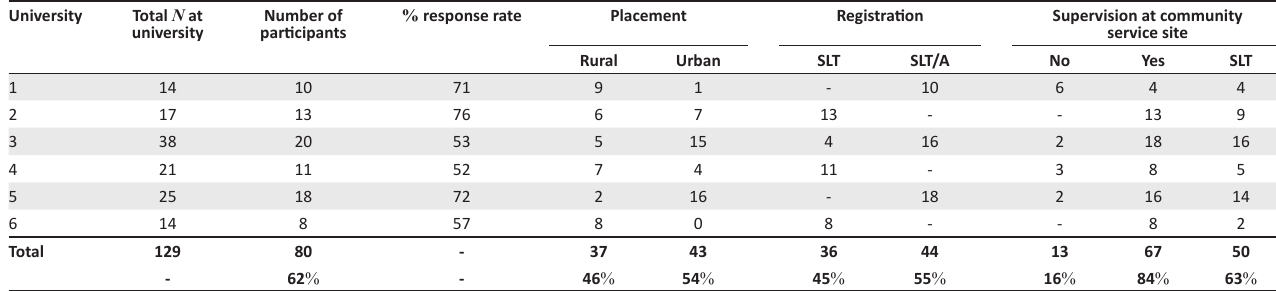
University Total N at